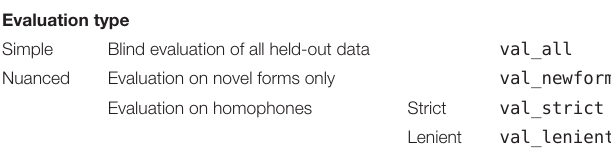
TABLE 4 | Types of model